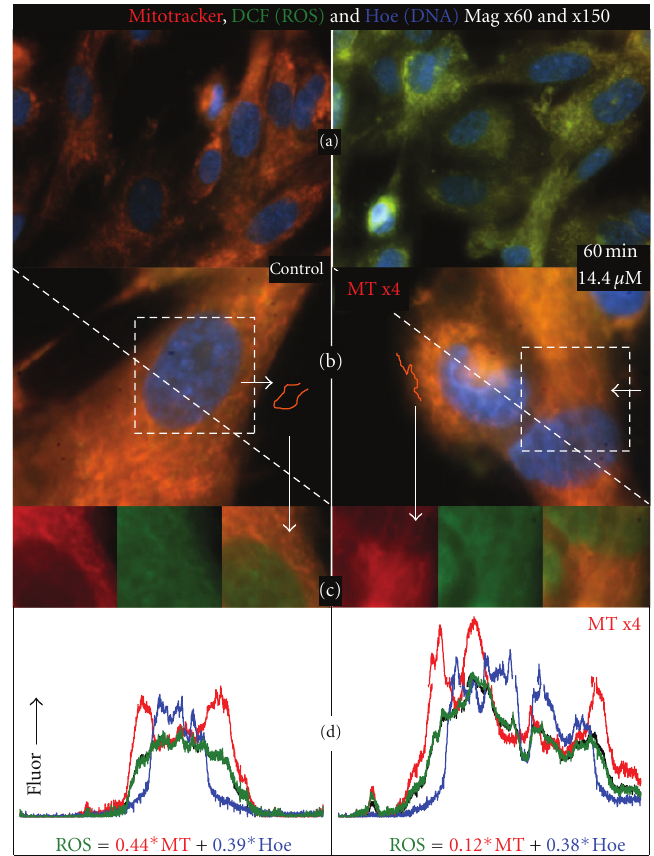
Figure 2: Colocalization of Mitotracker ( ΔΨ ) and DCF (peroxide) fluorescence in normal human astrocytes. Thimerosal induces oxidative stress at the mitochondrial level. High resolution images of control NHAs and NHAs treated for 60 minutes with 14.4 µ M Thimerosal. (a) Mitotracker (red), ROS-induced DCF (green), and nuclear Hoechst staining (blue) of NHAs at × 60 in the absence (left) and presence (right) of 14.4 µ M Thimerosal. (b) Images of control and treated cells obtained at × 150 magnification. An orange-colored “horseshoe” shaped signal in the control cell consists of a network of mitochondria which is mirrored in the ROS-induced DCF image. The same is demonstrated in the treated cells by a “lightening bolt” shaped mitochondrial network. (c) Square outlines of the cells from (b) highlighting individual Mitotracker and ROS images, and their overlaid images. (d) Intensity profile of MT, DCF, and Hoechst along the two diagonal lines in (b) (with the MT signal × 4 in the Thimerosal treated image). Red: MT signal, blue: Hoechst signal, green: ROS-generated DCF, black: fit to the ROS signal, based on the amplitudinal changes of MT and Hoechst. The two simulations indicate that four times the amount of DCF is generated by mitochondria in the ethylmercury-treated cells, but background cytosolic rates of generation are the